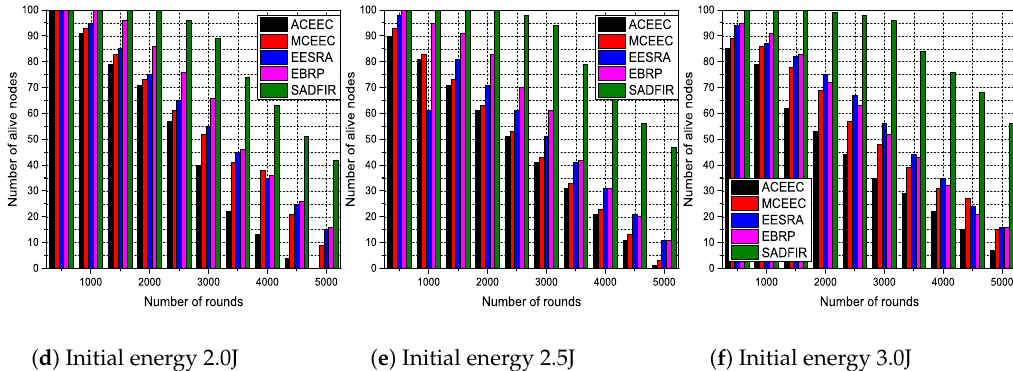
Figure 10. Number of alive nodes on different values of energy levels on different scales of network area.